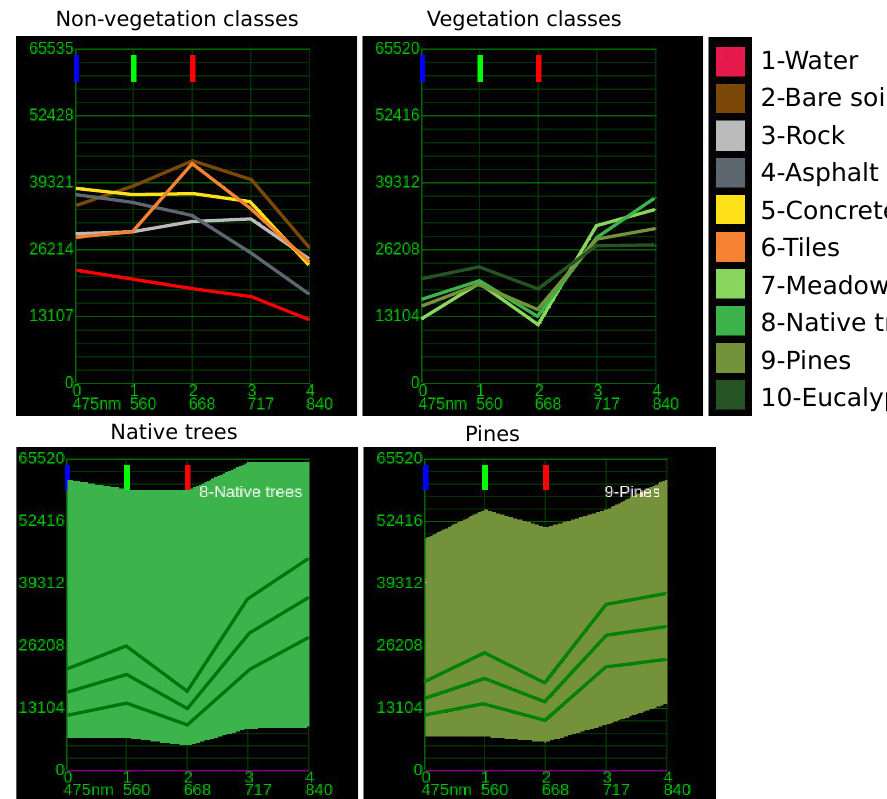
Figure 8. Five-band multispectral characteristics of the elements considered in this study. Top: Average spectrum of the non-vegetation and vegetation classes. Bottom: Mean value, standard deviation, and spectrum range of two specific classes, native trees and pines.